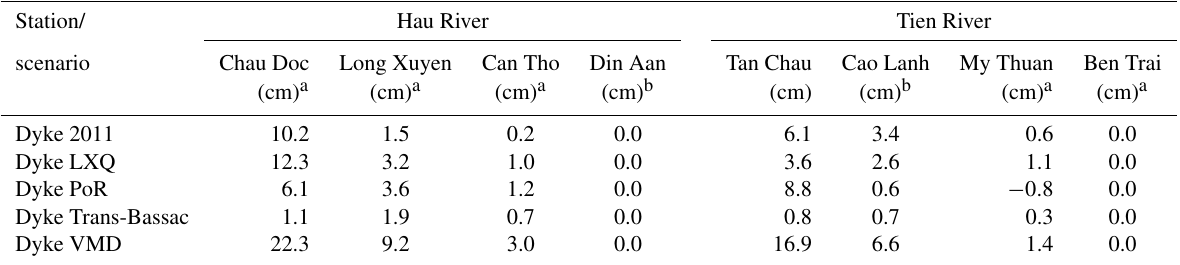
Table 2. Increases in the annual mean water levels (in cm) over the year 2000 at the selected stations along the Tien River and the Hau River under different high-dyke development